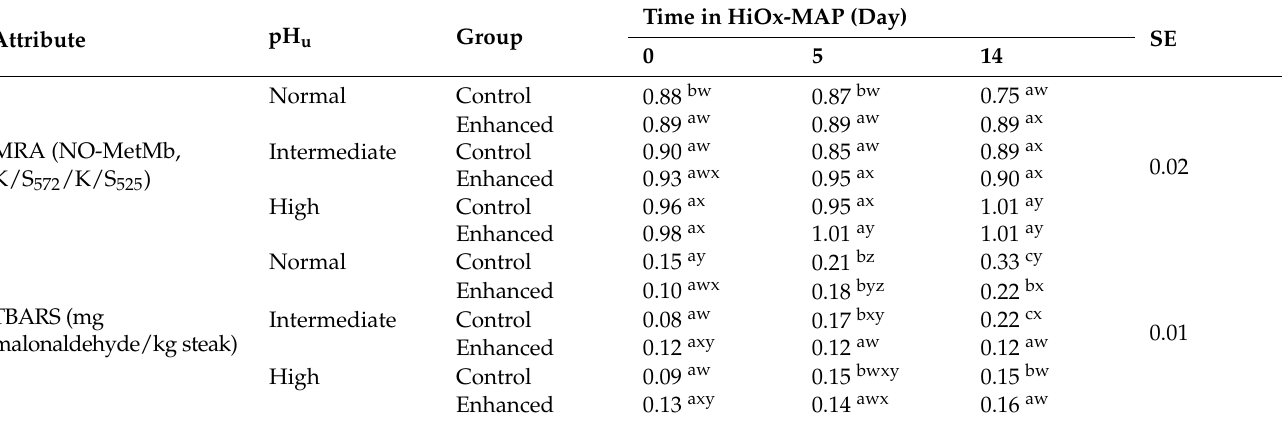
Table 5. Effects of treatment, ultimate pH (pH u ) and time on MRA and lipid oxidation (TBARS) of Nellore Longissimus lumborum steaks packaged in